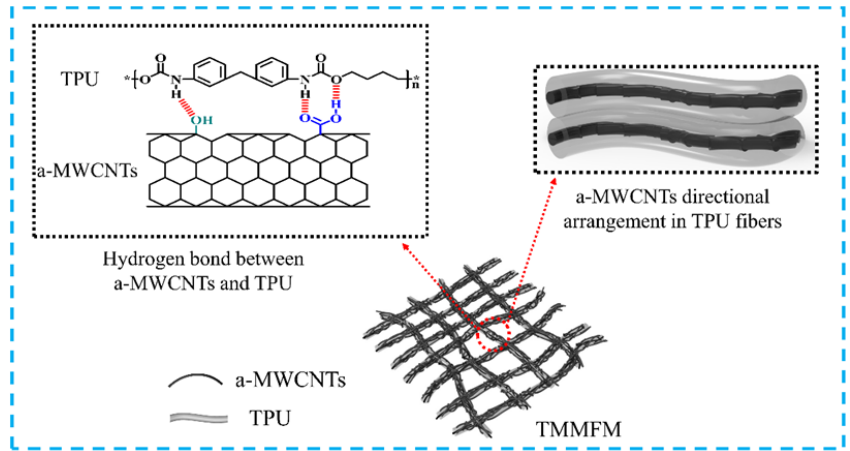
Figure 8. Thermal conductivity mechanical schematic diagram of TMMFM.